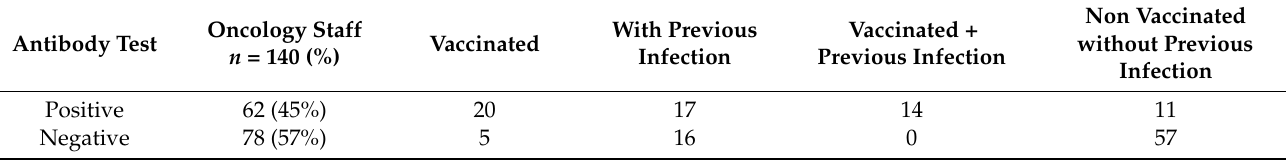
Table 2. Results of the rapid antibody test in the O.S.M. ( n = 140).